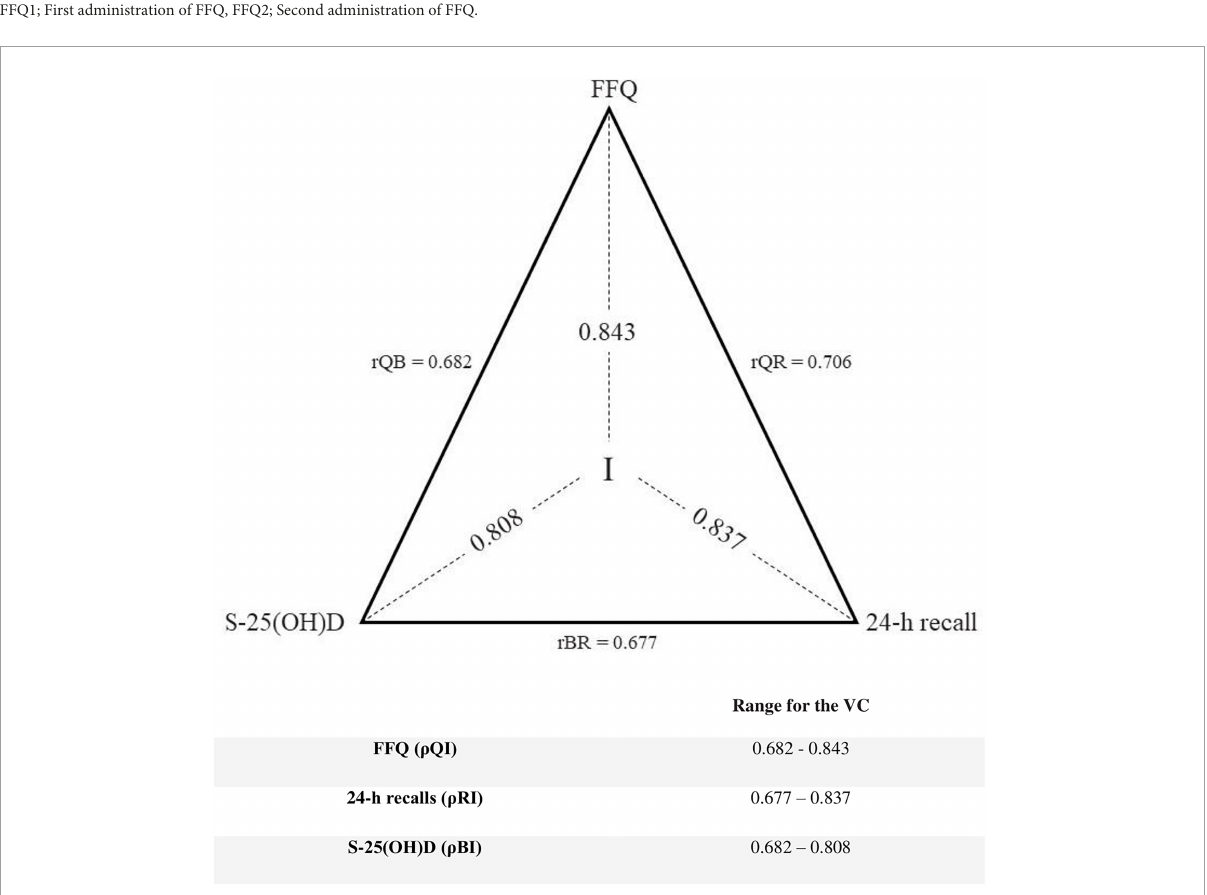
FIGURE2 Method of triads: The correlation coefficients (rQR, rRB, rQB) between vitamin D intake estimated by the FFQ1 (Q), the average of four 24-h recalls (R), and the biomarker (B) of vitamin D status [serum 25-hydroxyvitamin D (S-25(OH)D)] and validity coefficient (VC)s (QI, BI, RI) between true intake (I) and estimated intakes. The lower limit is rQB for the FFQ and biomarker, and rBR for the 24-h recalls, while the maximum limit is determined using the triads method ( n =